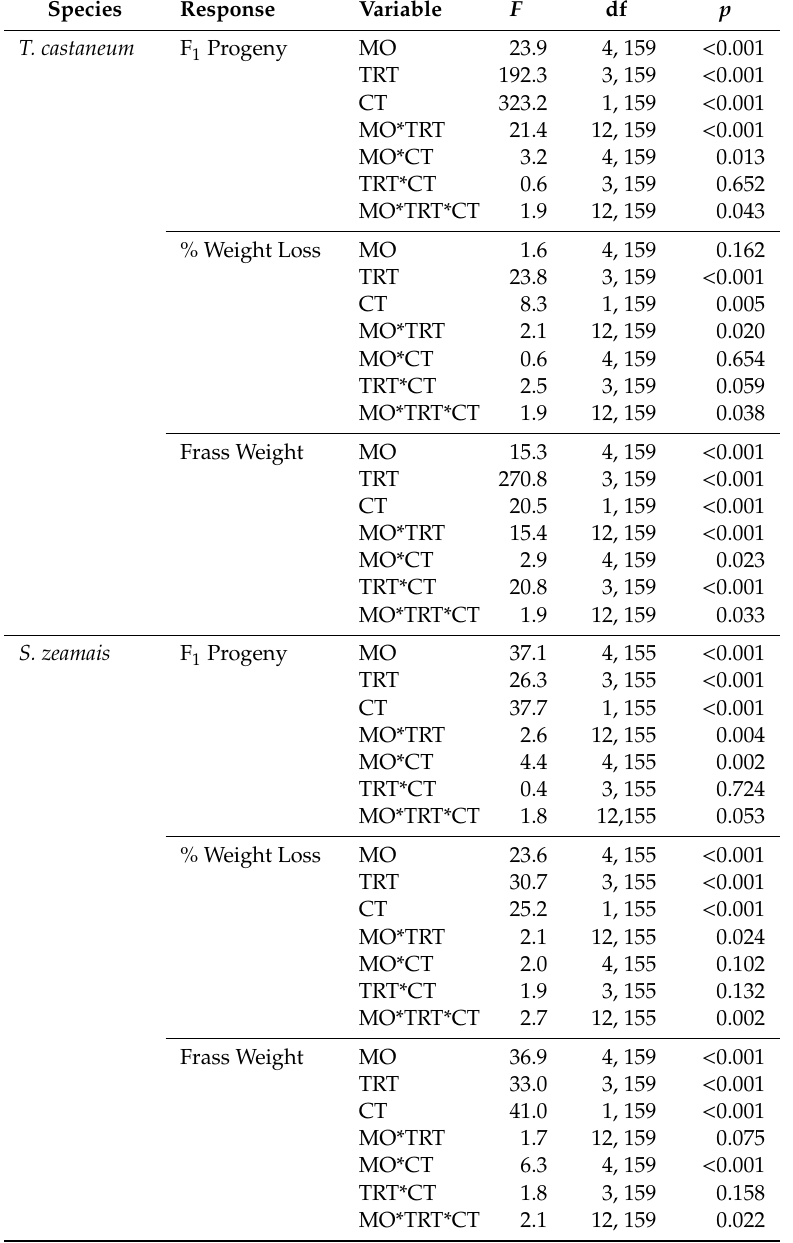
Table 8. ANOVA Table for main e ff ects month (MO), treatment (untreated controls, two rates of Diacon IGR + , and the Gravista formulation), and count (CT, parental insects removed after 7 days or left continuously on the corn for 8 weeks), and all associated interactions, for T. castaneum and S. zeamais F 1 progeny, % of sample weight loss, and weight in grams of feeding